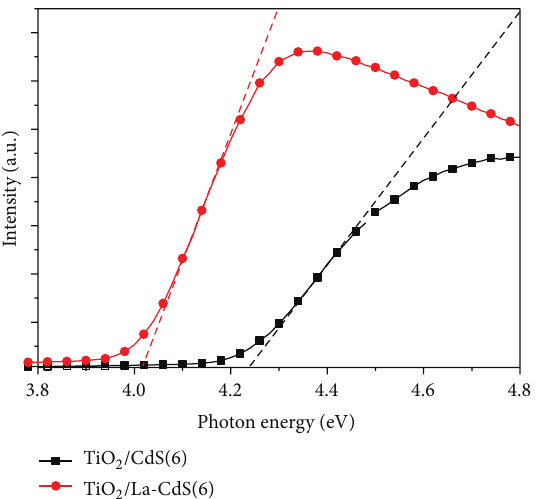
Figure 11: IPCE curves of La-doped-CdS(6)/CdSe(4) and CdS(8)/ CdSe(4)